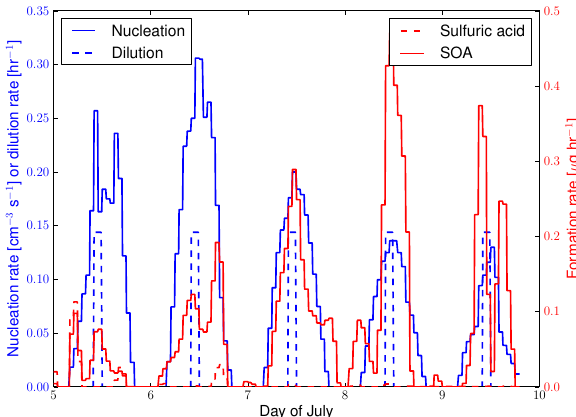
Fig. 3. Time-dependent inputs to TOMAS box model of Raven’s Nest. Nucleation is estimated from SO 2 measurements, H 2 SO 4 condensation sink measurements from the SMPS, and estimated total downwelling solar radiation using the method of Pet¨aj¨a et al. (2009). Dilution with clean FT air is estimated from the aver- age drop in aerosol concentrations between 09:00 and 11:00a.m. during these 5 days measured by the SMPS. Sulfuric acid and SOA formation rates are estimated from AMS measurements and have been corrected for